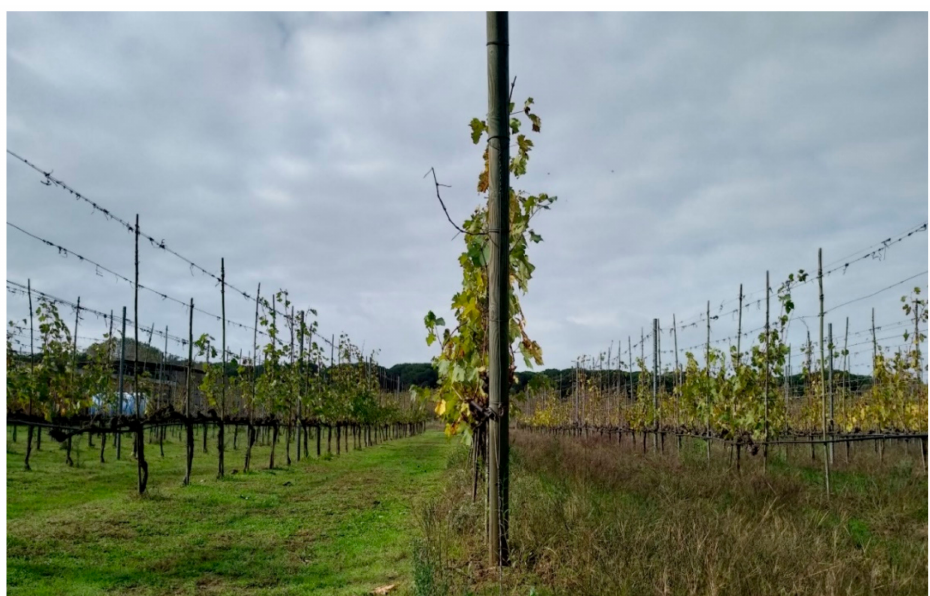
Figure 3. Effects of different management systems on vineyard floor canopy height after two years of treatments. Left : AM plots; Right : conventional management (CM) plots.